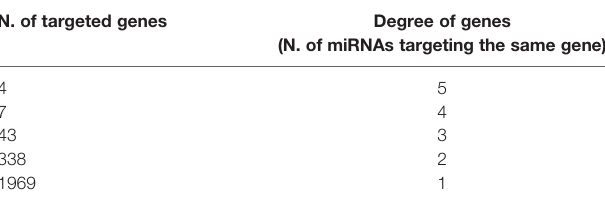
TABLE 2 | Degree of putative genes in miRNA-Target Interaction Network (MTis).